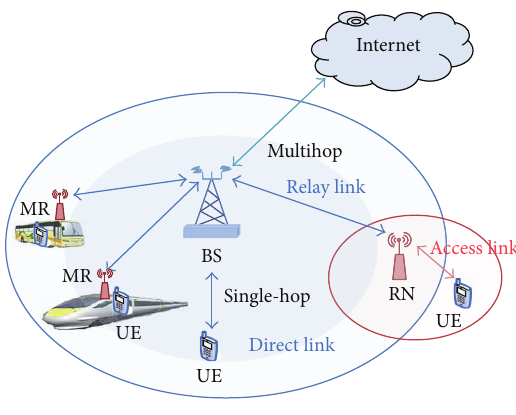
Figure 1: Relay nodes scenarios.